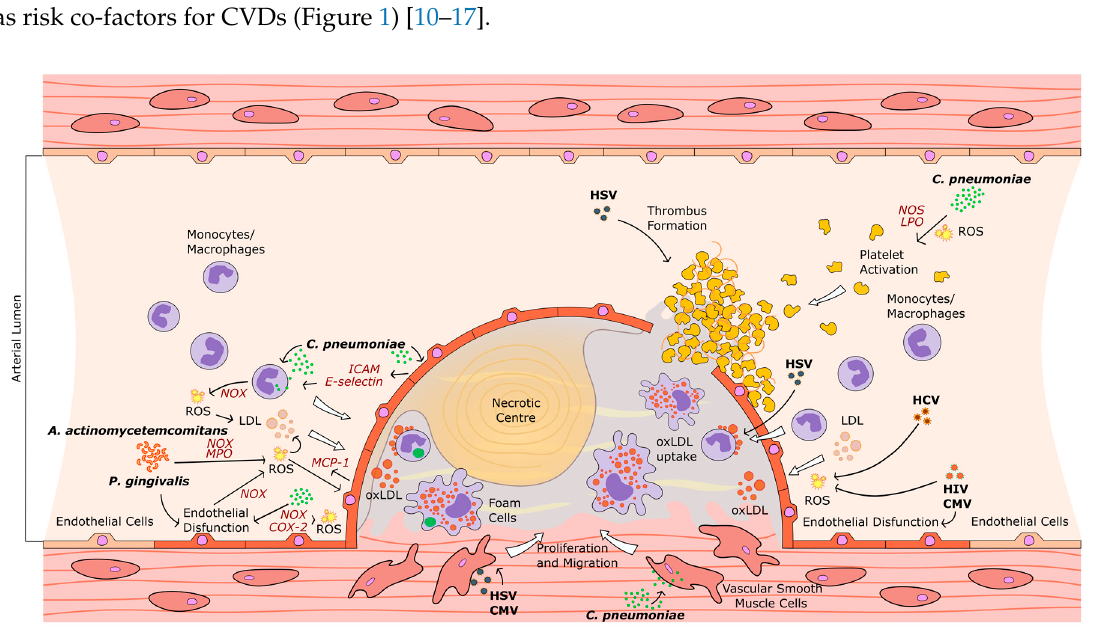
Figure 1. Putative pathways of infectious agent-mediated oxidative stress in several stages of the atherosclerotic process. C. pneumoniae , HIV, HCV, HSV, and CMV contribute to endothelial dysfunction; P. gingivalis , A. actinomycetemcomitans , C. pneumoniae , HIV, HCV, and CMV trigger LDL oxidation; P. gingivalis , C. pneumoniae , and CMV induce macrophage-derived foam cell formation; P. gingivalis , C. pneumoniae , HSV, and CMV contribute to progression of atherosclerotic plaque (ICAM: intercellular adhesion molecule; NOX: nicotinamide adenine dinucleotide phosphate oxidase; MPO: myeloperoxidase; NOS: nitric oxide synthase; COX-2: cyclooxygenase-2; LPO: lipoxygenase).